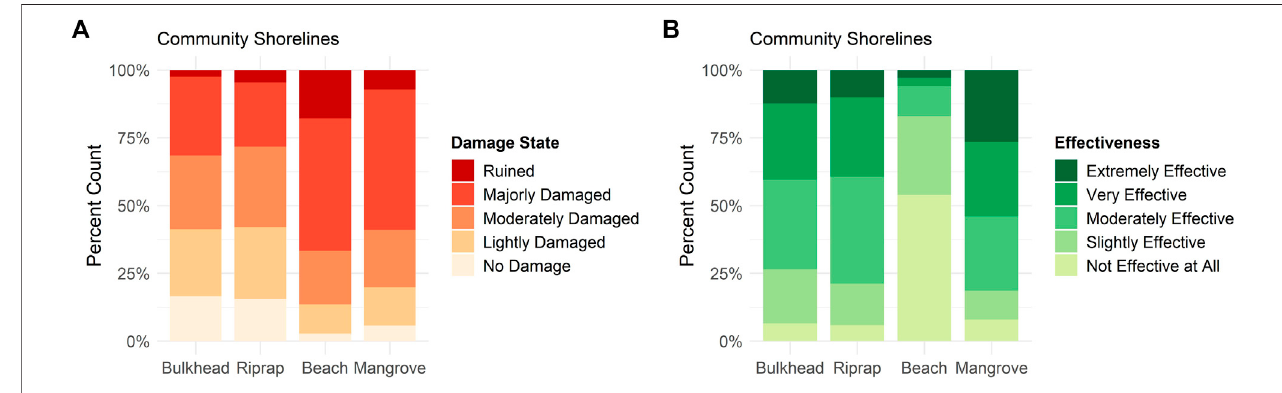
FIGURE 2 | Perceptions of community-level shorelines, both the reported damage state (A) and the coastal protection effectiveness (B) .